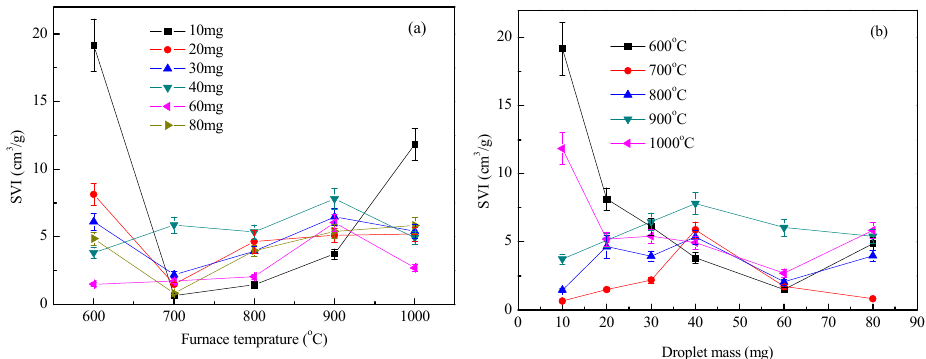
Figure 7. Waste liquor SVI under air condition: ( a ) SVI with furnace temperature; ( b ) SVI with droplet mass.